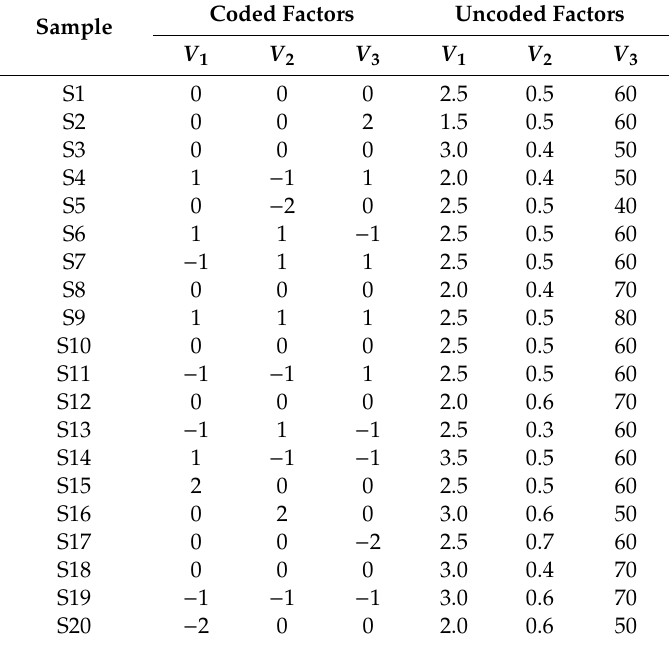
Table 3. Design matrix.